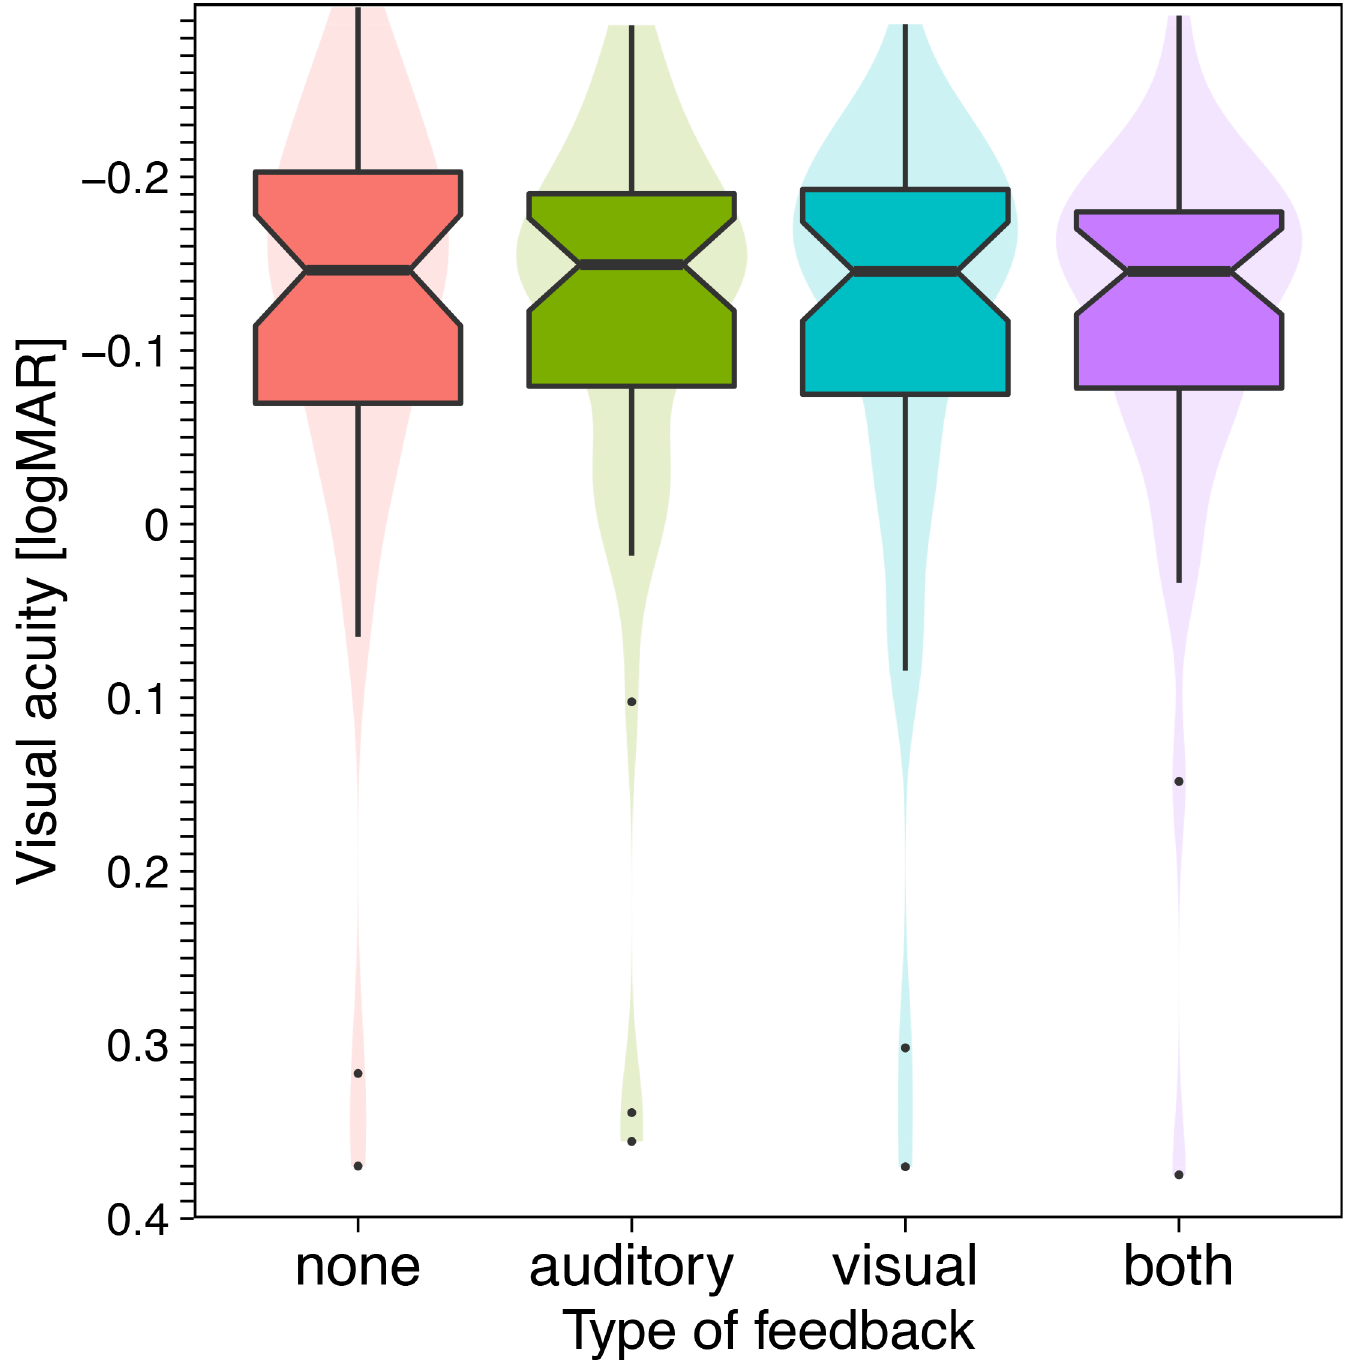
Fig 2. Acuity results (in logMAR, negative values at the top) across the four different feedback conditions. Most acuities are between – 0.1 and – 0.2 logMAR, and thus normal, but there are low acuity outliers. The feedback condition has no noticeable effect on visual acuity. [Box plot details: thick horizontal bar: median. Notch: 95% confidence interval of the median. Box: interquartile range (25% – 75%). Whiskers: range. Dots: outliers (data > 1.5 times the interquartile range off the box). The ‘‘ violin plots ” in the background visualize a smoothened density estimate.]